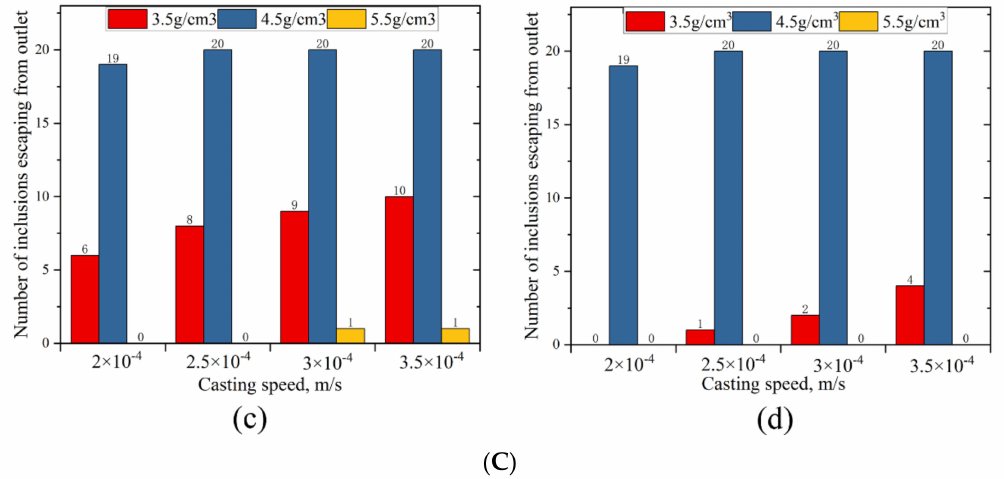
Figure 6. ( A ) Number of inclusions escaping from the outlet with different diameters and densities at casting velocities of (a) 2 × 10 − 4 , (b) 2.5 × 10 − 4 , (c) 3 × 10 − 4 , and (d) 3.5 × 10 − 4 m/s with a pouring temperature of 2273 K. ( B ) Number of inclusions escaping from the outlet with different diameters and casting velocities at densities of (a) 3.5, (b) 4.5, and (c) 5.5 g/cm 3 with a pouring temperature of 2273 K. ( C ) Number of inclusions escaping from the outlet with different densities and casting velocities at diameters of (a) 10, (b) 40, (c) 70, and (d) 100 µ m with a pouring temperature of 2273